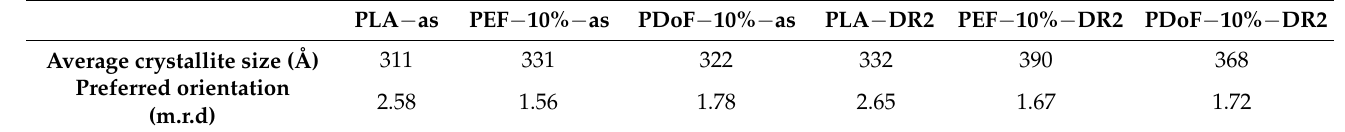
Table 3. Semi − quantitative results of the XRD data modellization.